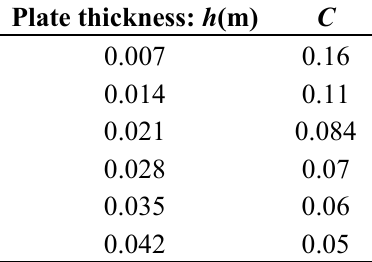
Table 3. Coefficient C